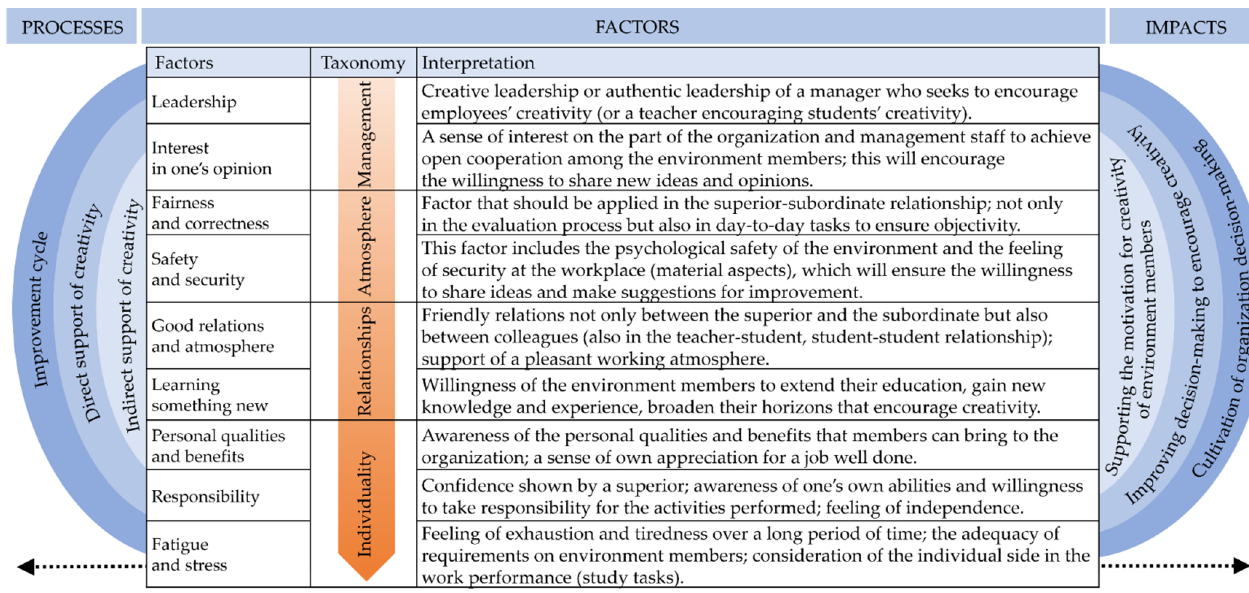
Figure A2. Taxonomy of the factors affecting sustainable creativity.